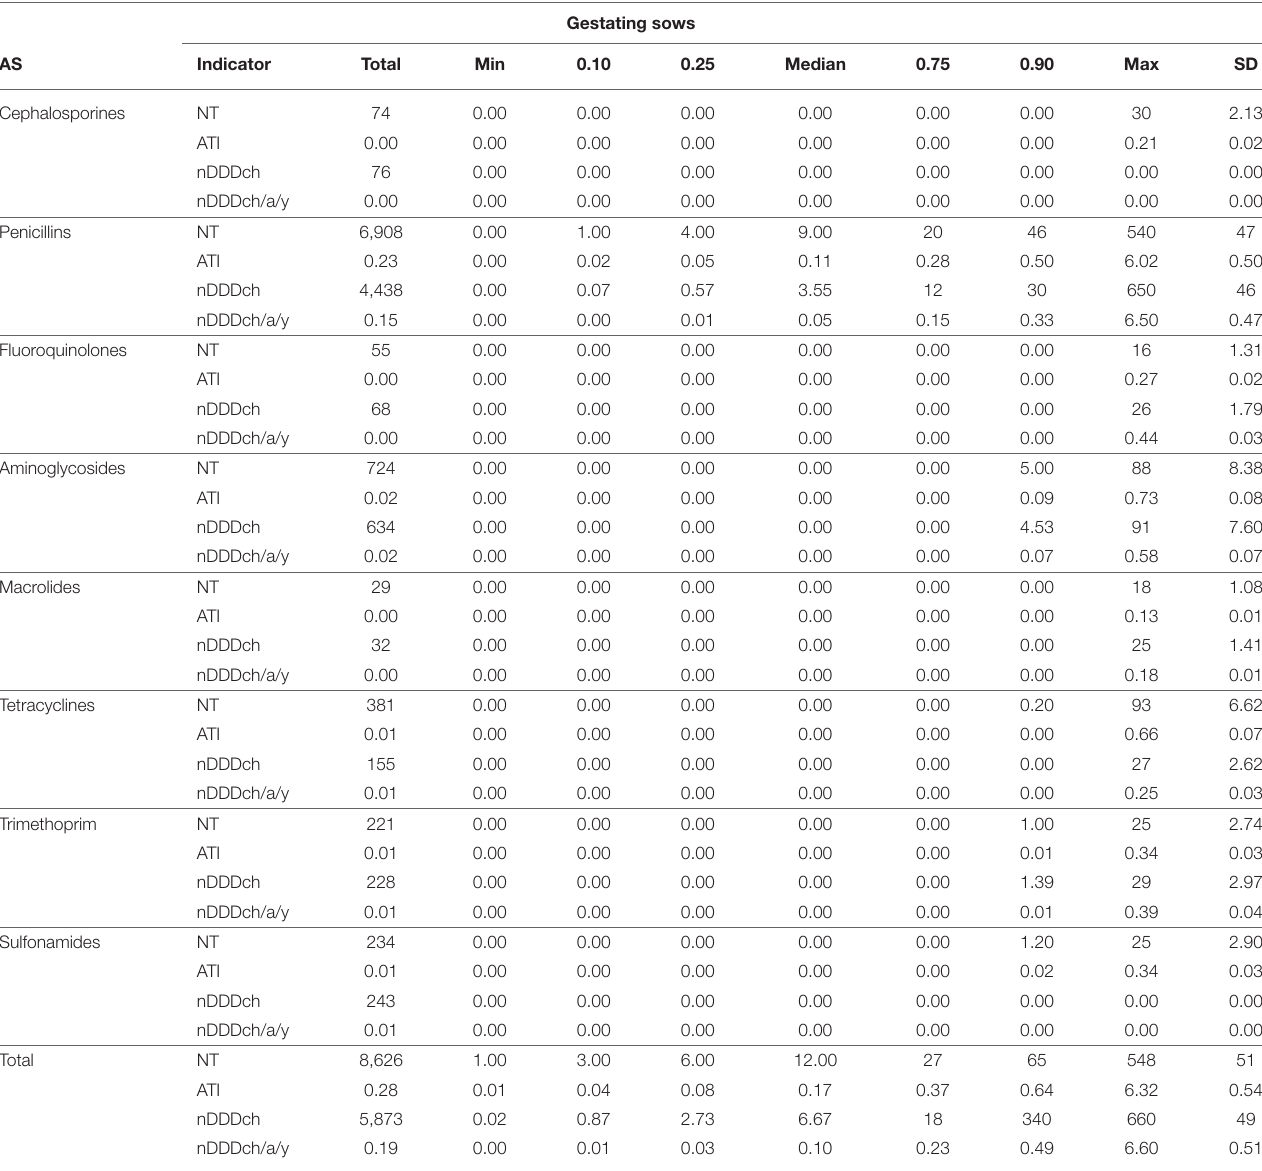
TABLE 6 | Total, minimum (min), median, maximum (max), 10% (0.1), 25% (0.25), 75% (0.75), 90% (0.9) percentiles and standard deviation (SD) of AMU in gestating sows of the study farms measured using the indicators NT, ATI, nDDDch and nDDDch/animal/year (nDDDch/a/y) displayed by active substance